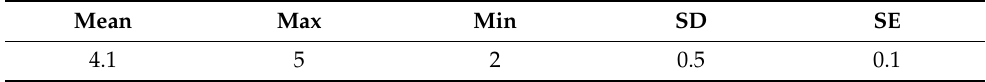
Table 14. Descriptive statistics for items regarding system